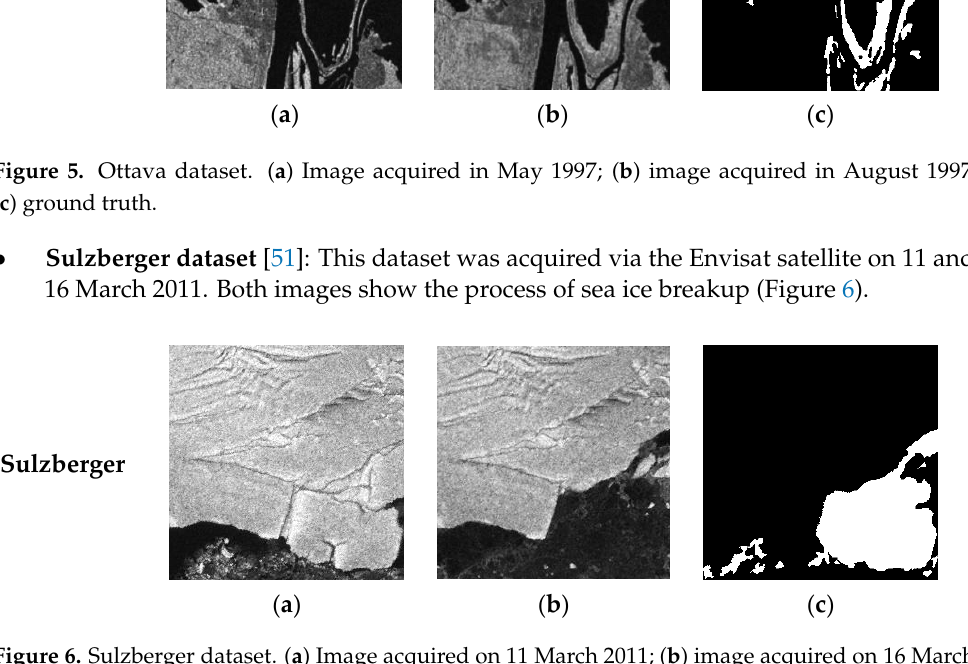
( c ) Figure 7. Yellow River dataset. ( a ) Image acquired in June 2008; ( b ) image acquired in June 2009; ( c ) ground truth.